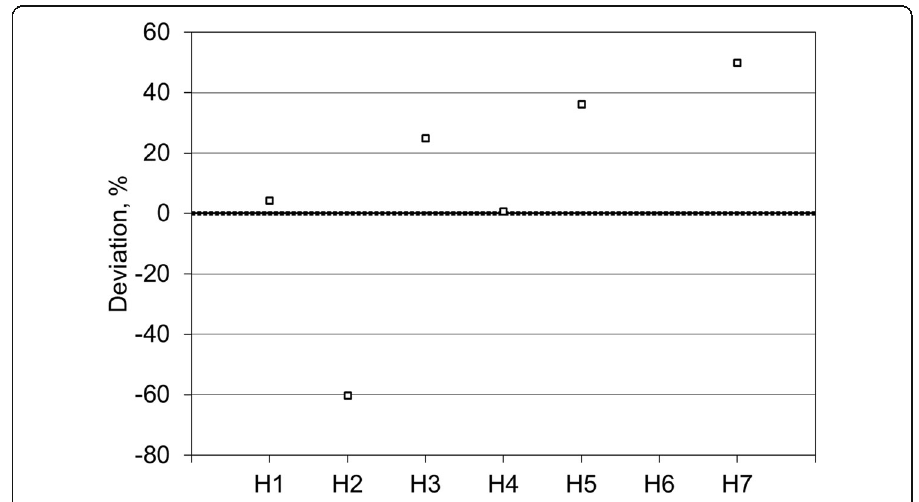
Fig. 4 Participants reported volumes for the outer shell of the comparison